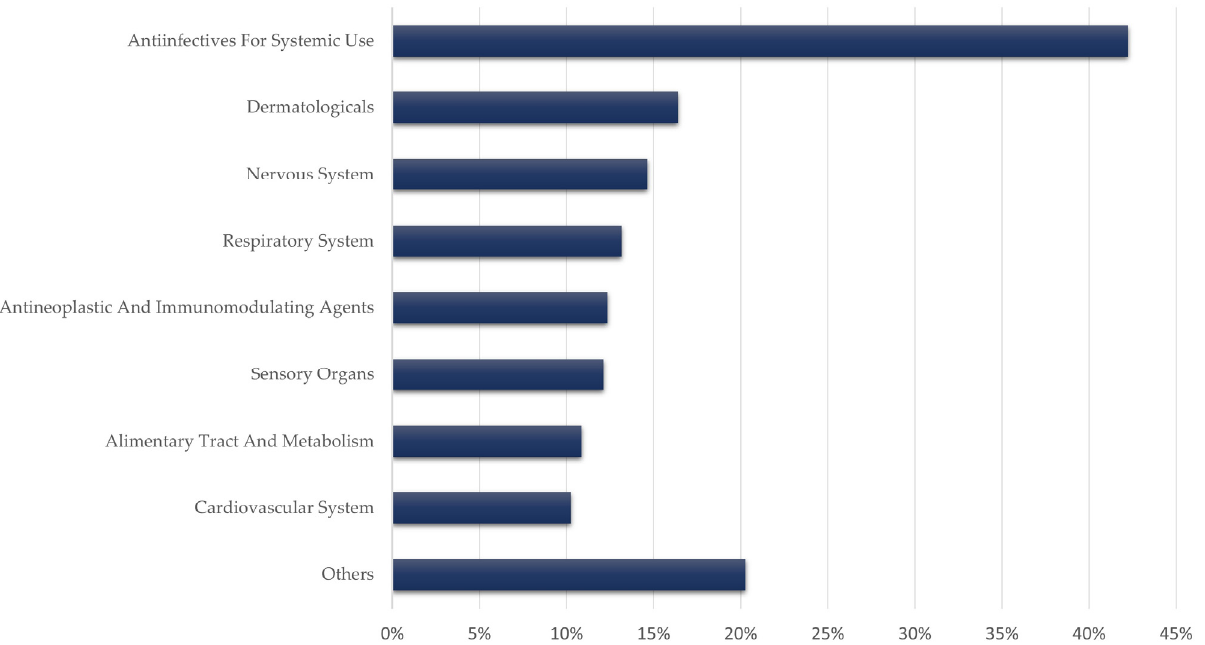
Figure 2. Main Anatomical Therapeutic Chemical (ATC) classes involved in parosmia